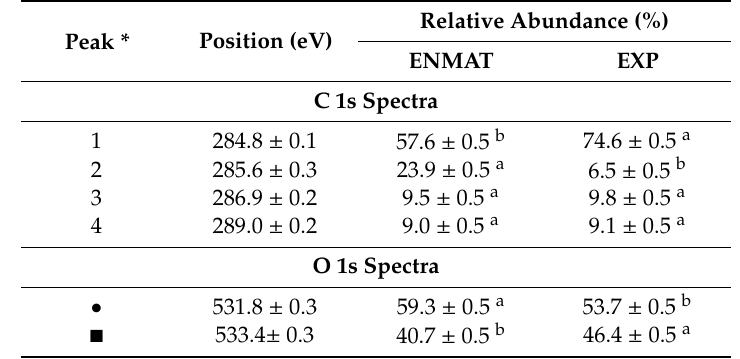
* Peak symbols refer to Figure 6E. The data are the means of three independent experiments ± standard deviations ( n = 3). a,b Values in the same raw, with different superscript letters, differ significantly ( p < 0.05).